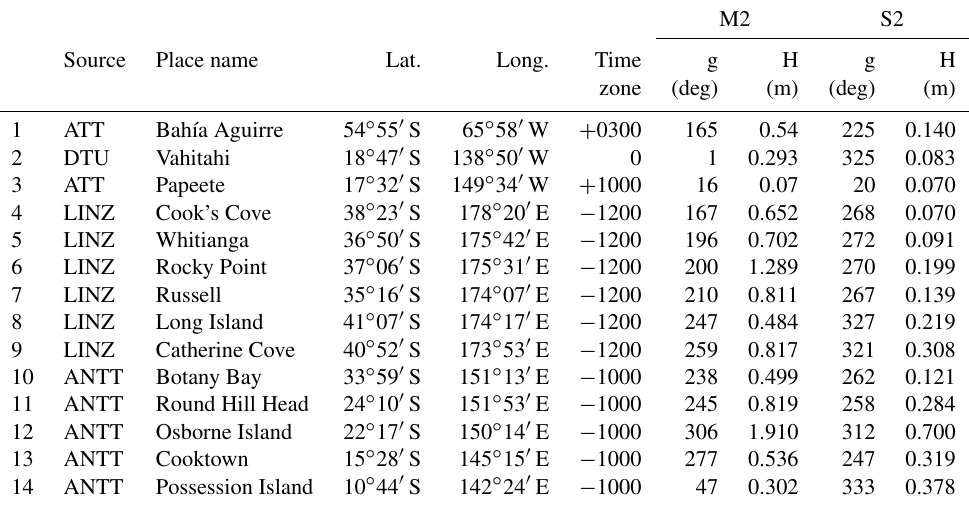
Table 2. Locations with modern tidal measurements, as near as possible to those reported by Cook in Table 1. The final columns give the tidal constants for the M2 and S2 constituents (phase lag (g) in degrees and amplitude (H) in metres) as computed in the time zone shown (the number of hours west of Greenwich × 100). The constants were obtained from the Admiralty Tide Tables (ATT), Australian National Tide Tables (ANTT), Land Information New Zealand (LINZ), and the global tide model of Cheng and Andersen (2010) from the Technical University of Denmark